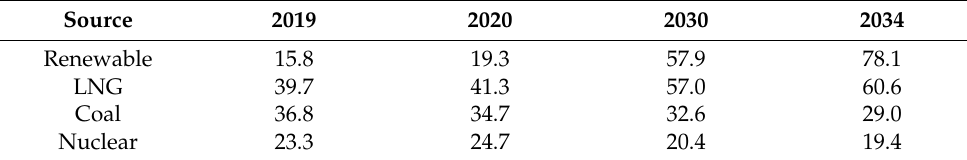
Table 1. The 9th Basic Plan for Long-Term Electricity Supply and Demand. Source